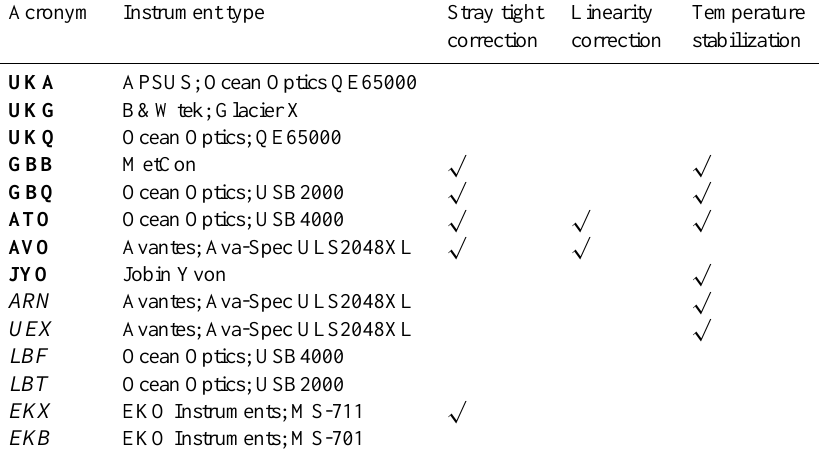
Table 1. Array spectroradiometer instruments participating at the intercomparison: instruments from the first group are from end users who worked in close collaboration with the EMRP ENV03 project; they are indicated in bold. External instruments from the second group are highlighted in italic. The specific configurations in terms of stray light correction, linearity correction and temperature control are marked. Acronym Instrument type Stray tight Linearity Temperature correction correction stabilization UKA APSUS; Ocean Optics QE65000 B&Wtek; Glacier